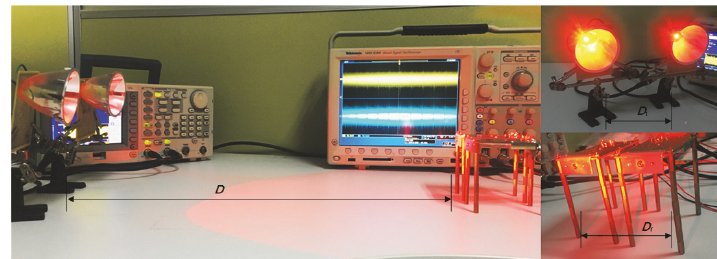
Figure 2: Experimental setup of the switching MIMO VLC system with adaptive OFDM modulation.